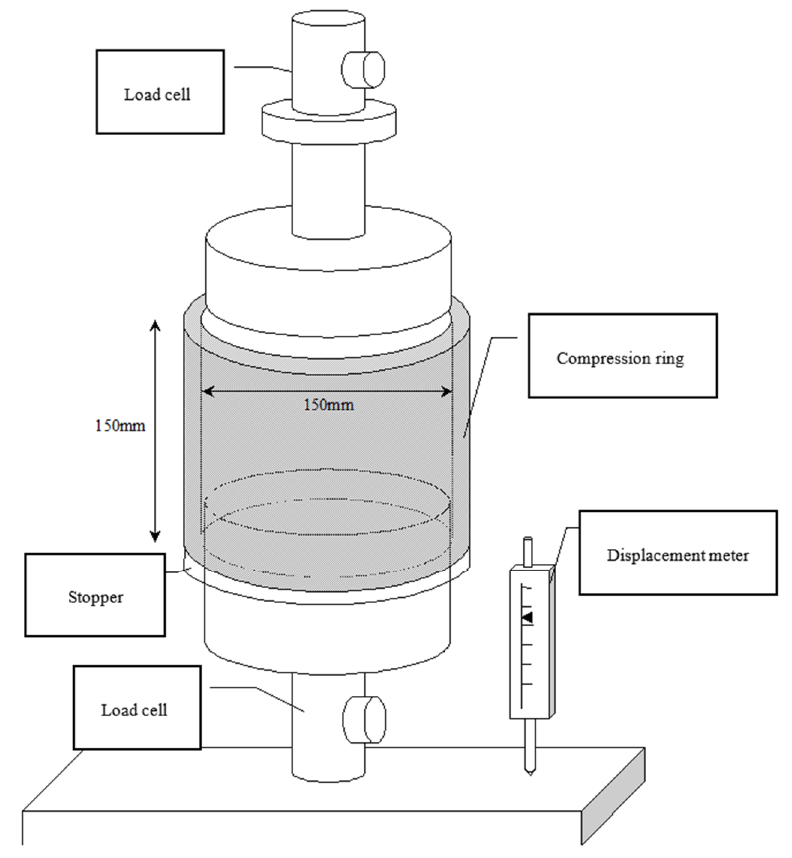
Figure 2. Large 1D compression tester.